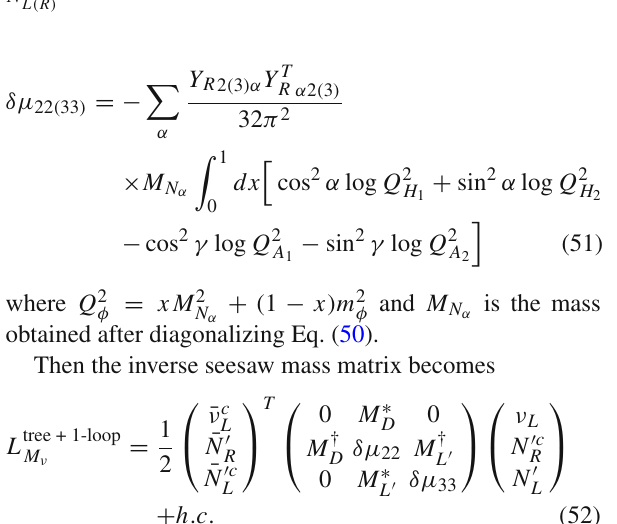
Fig. 2 The one-loop diagram generating Majorana mass terms of N